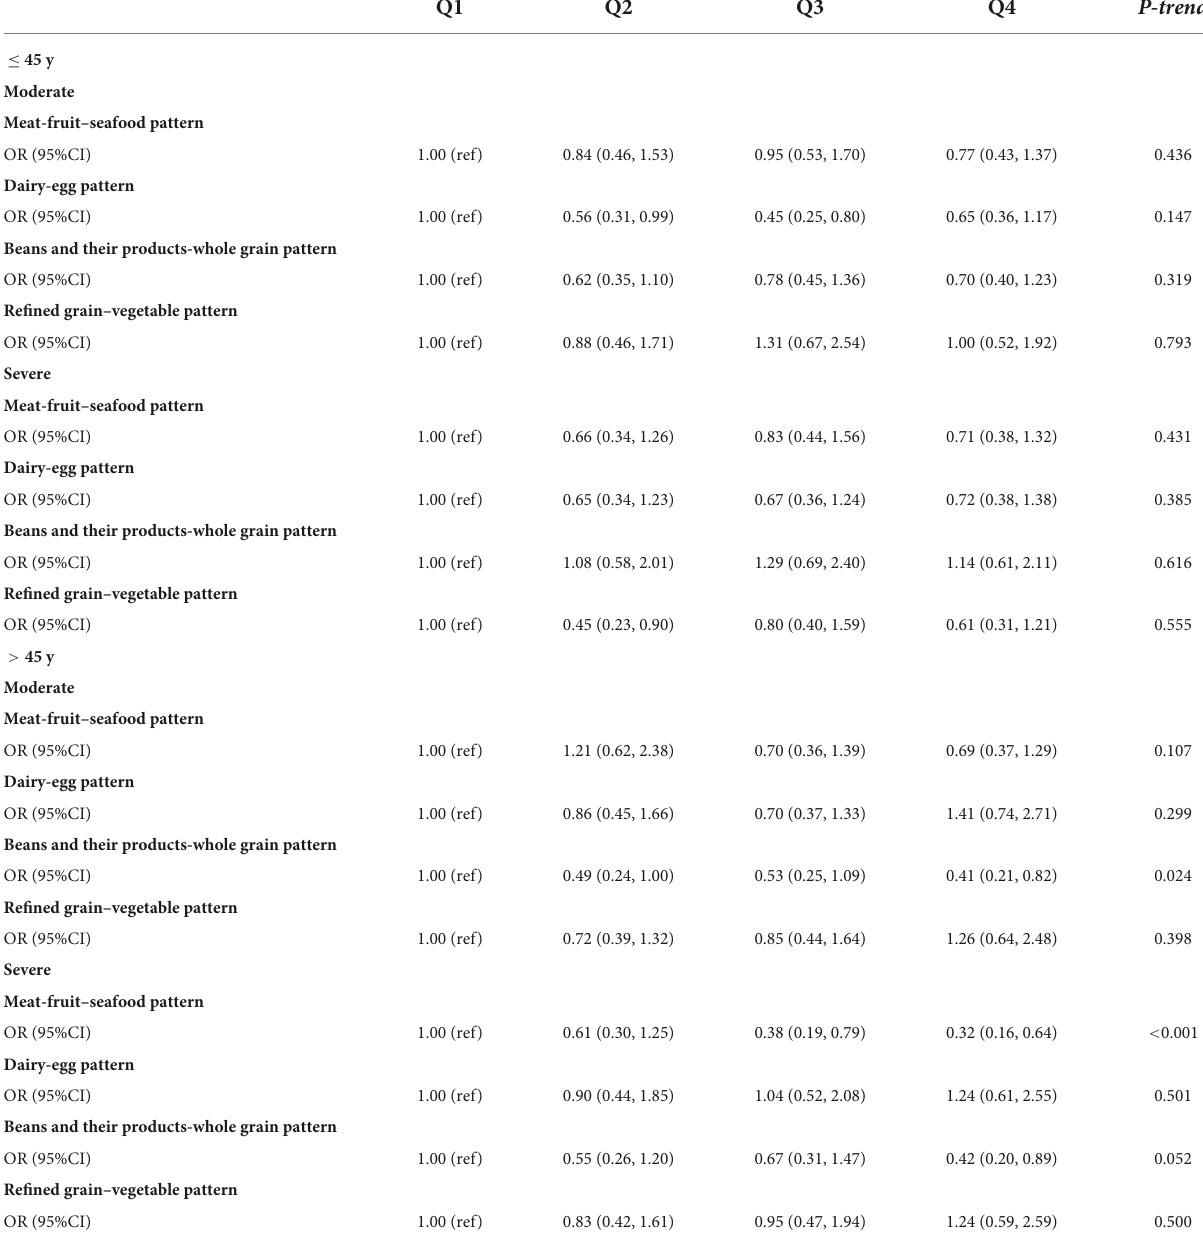
TABLE 4 Associations between dietary pattern score quartile and initial clinical manifestations, stratified by age. Q1 Q2 Q3 Q4